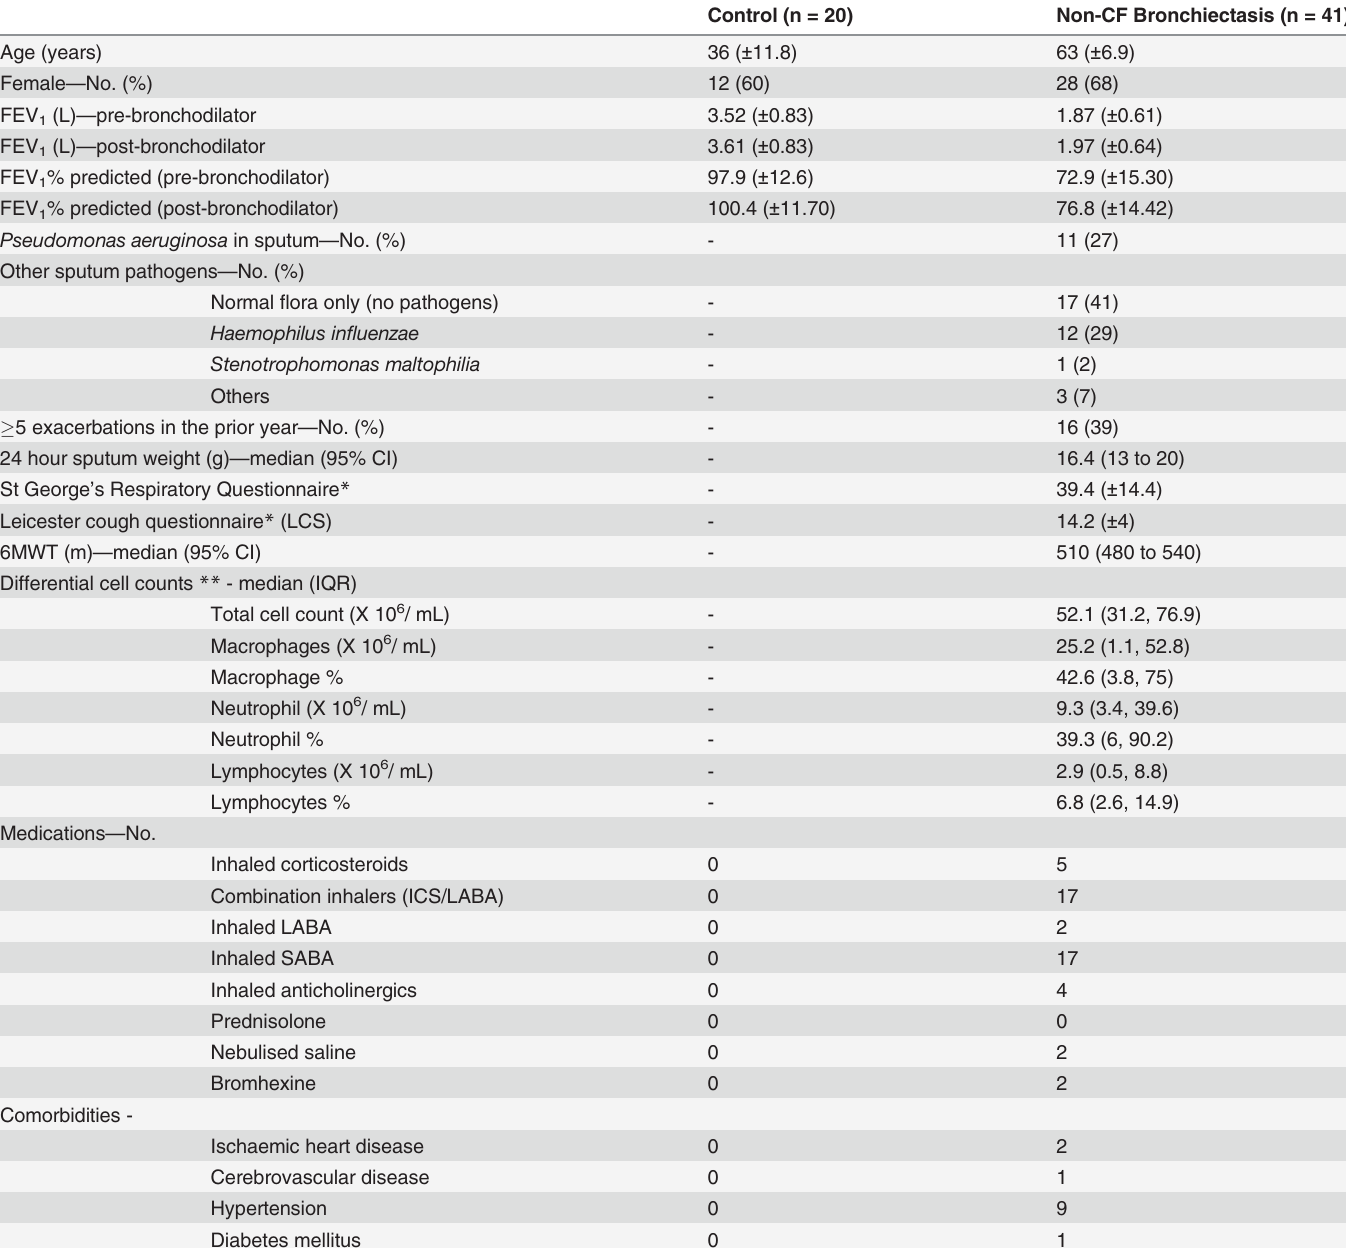
Table 1. Subject demographics and disease